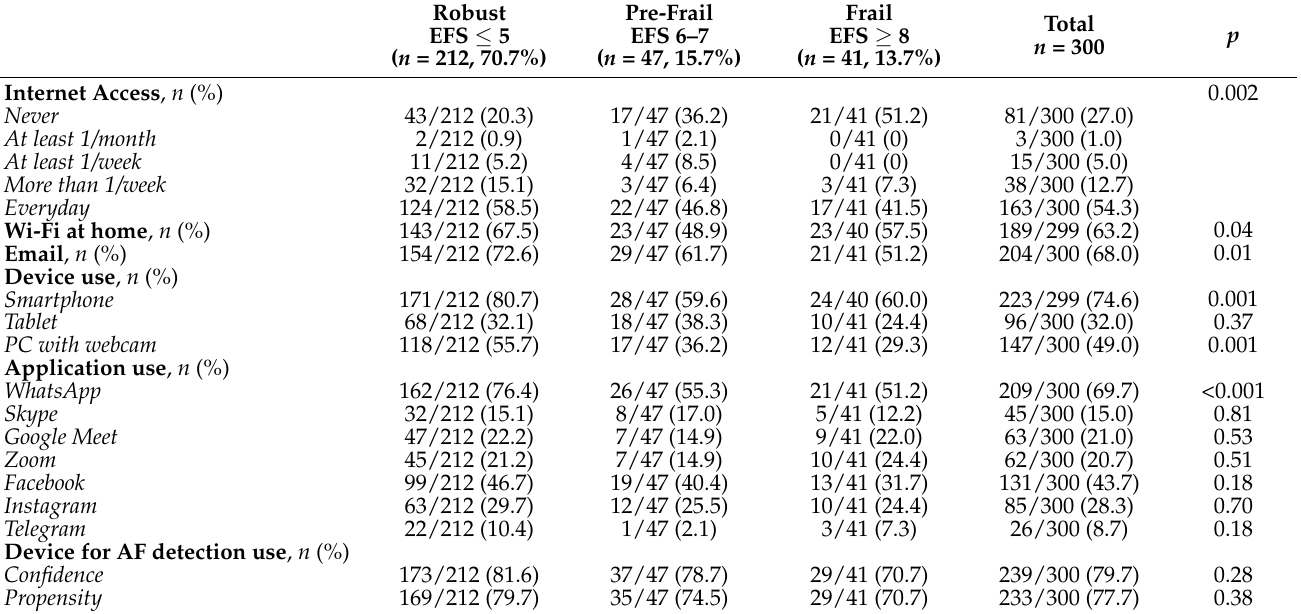
Table 2. Characteristics of Internet access and use of digital tools stratified for frailty status according to the Edmonton Frail